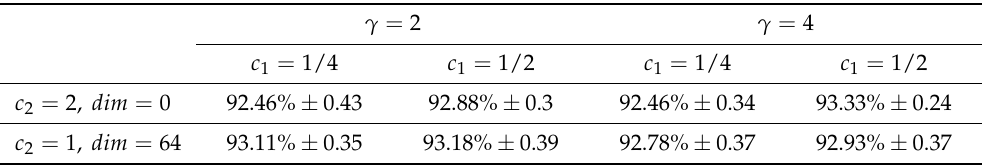
Table 4. Mean and std. of the values of the accuracy obtained on MedMNIST2D OrganSMNIST dataset by the LRBS approach in a maximum of 50 epochs and different values of the hyperparameters. The initial mini-batch size is n 0 = 64 and the initial learning rate is η 0 = 10 − 2 .